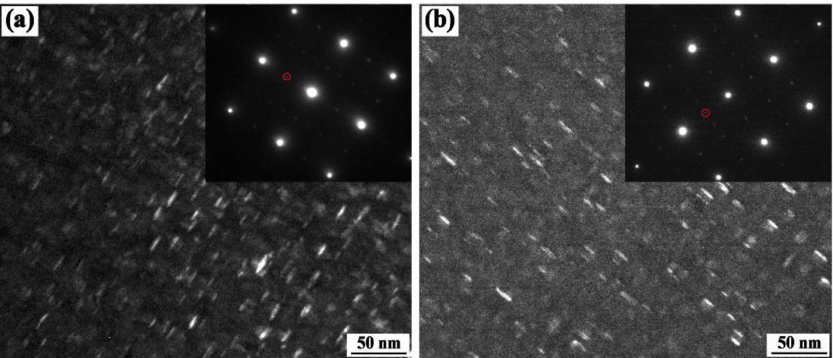
Figure 4. Dark-field TEM images and the corresponding SAED pattern in [001] zone axis: ( a ) alloy 1 and ( b ) alloy 4, imaged using (100) reflection.